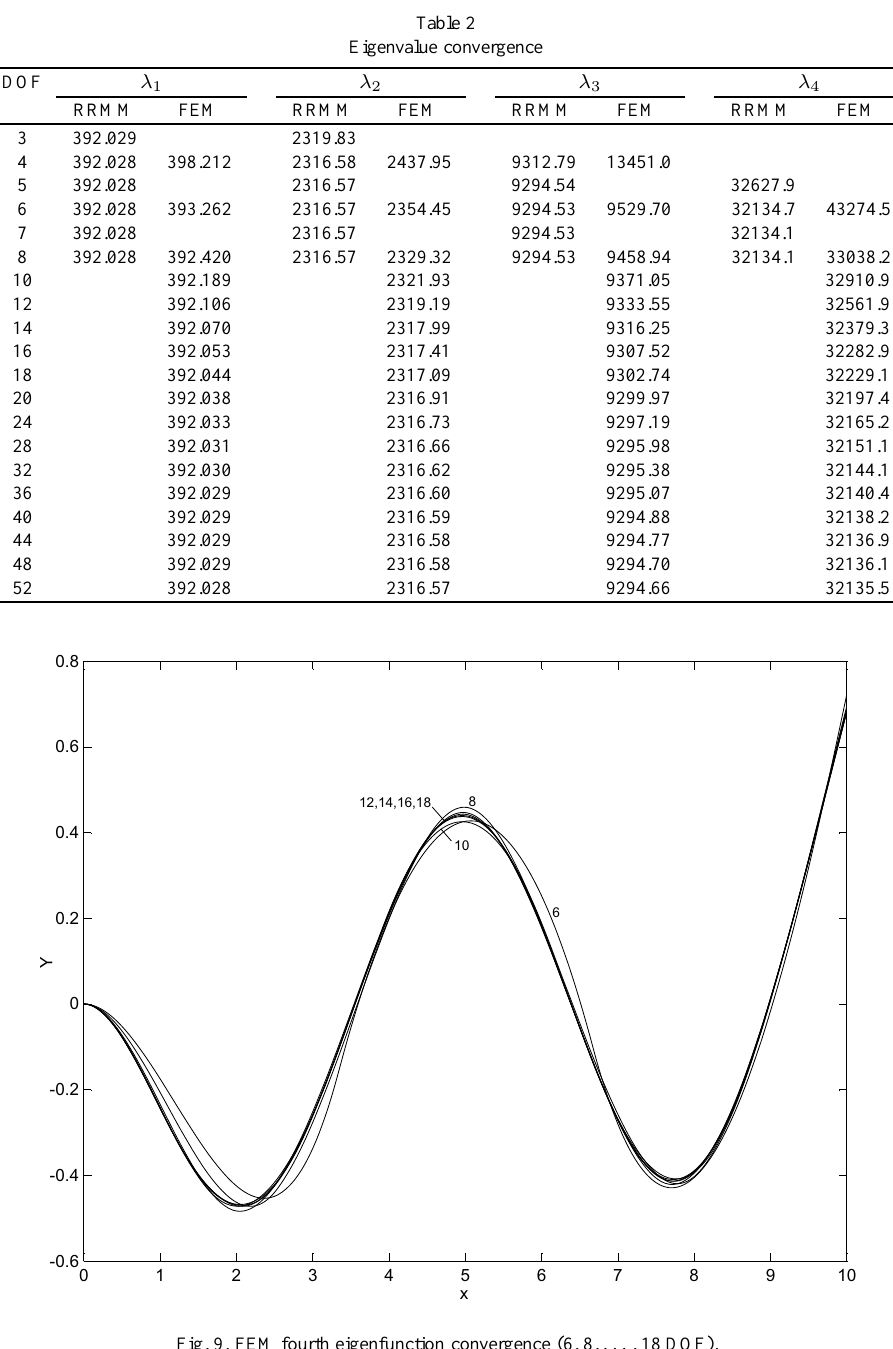
Fig. 9. FEM fourth eigenfunction convergence (6, 8, ... , 18